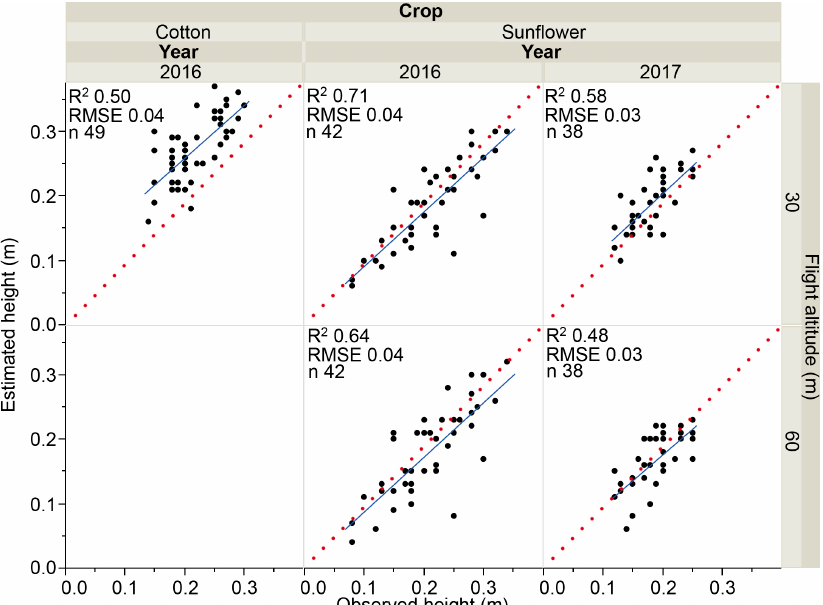
Figure 7. OBIA-based estimated height vs. observed height as affected by crop, fight altitude and year. The root mean square error (RMSE) and correlation coefficient ( R 2 ) derived from the regression fit are included for every scenario ( p < 0.0001). The solid line is the fitted linear function and the red dotted line is the 1:1 line.